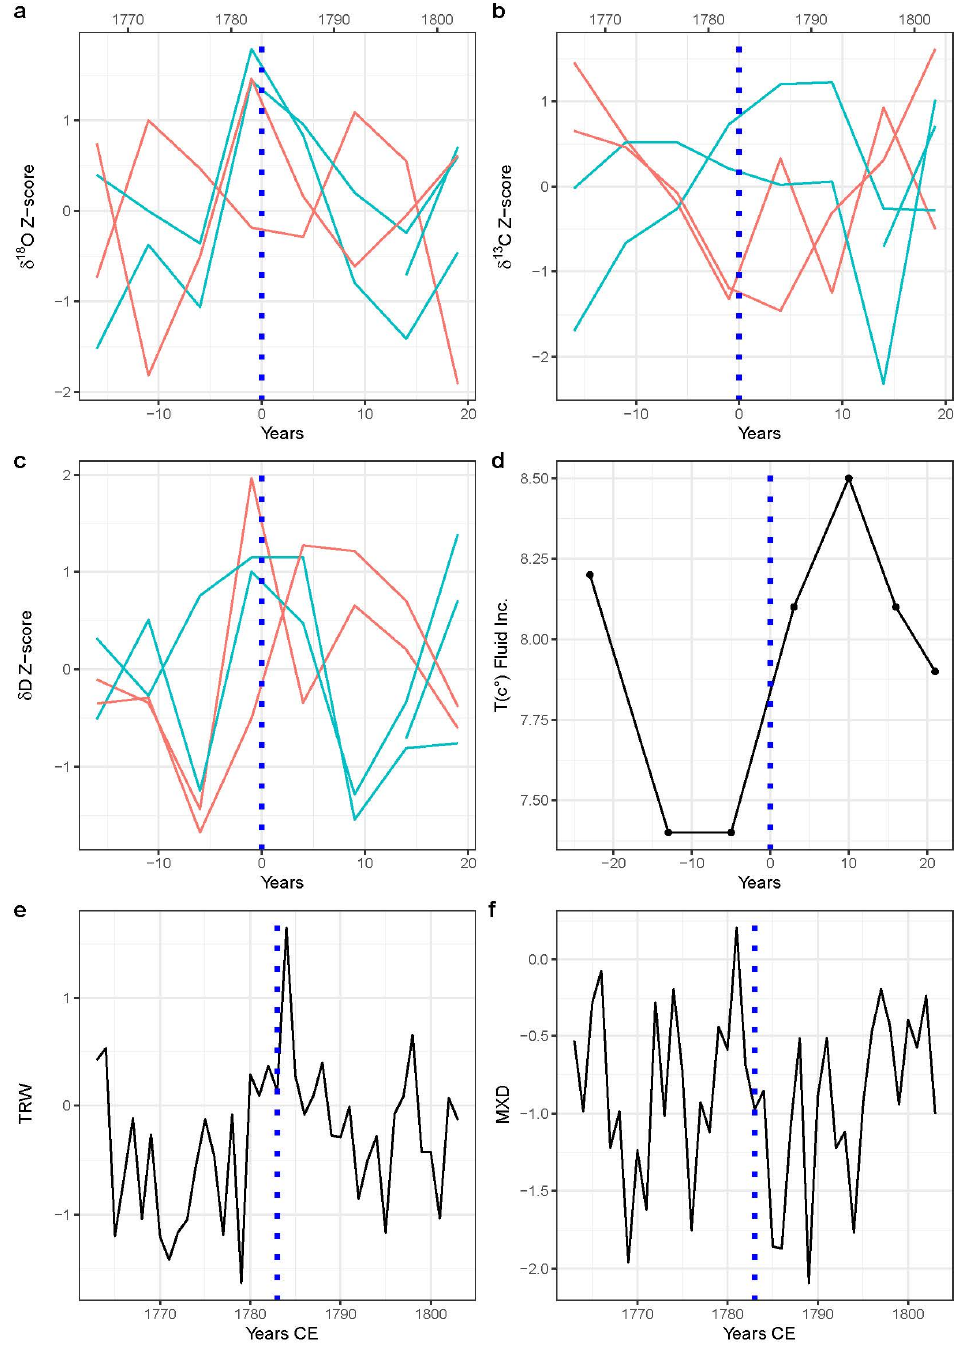
Figure 6. Plots of tree-ring cellulose isotopes and climate proxies in the period of the Laki eruption: ( a ) δ 18 O of two larch trees (red) and of two cembran pines (blue) with 5-year resolution. ( b ) δ 13 C of the trees above. ( c ) δ D of the trees above. ( d ) Temperature reconstruction from fluid inclusions from Milandre Cave. ( e ) The temperature reconstruction based on TRW by Büntgen et al., 2011. ( f ) The temperature reconstruction based on MXD by Büntgen et al., 2006. The dotted vertical line indicates the eruption year (1783